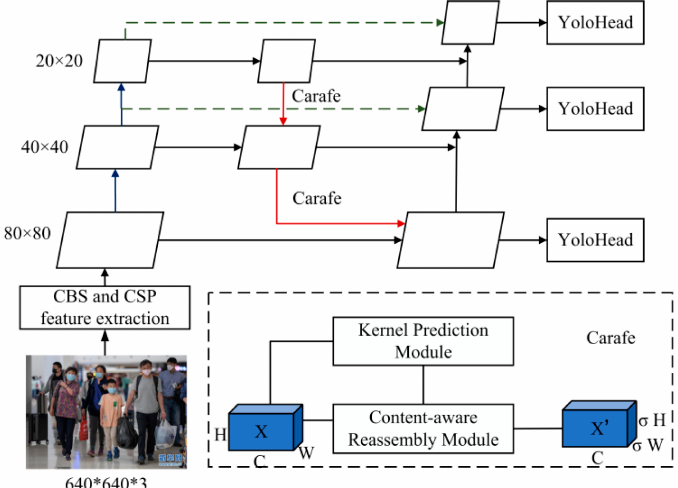
Figure 6. C-FPN structure diagram.